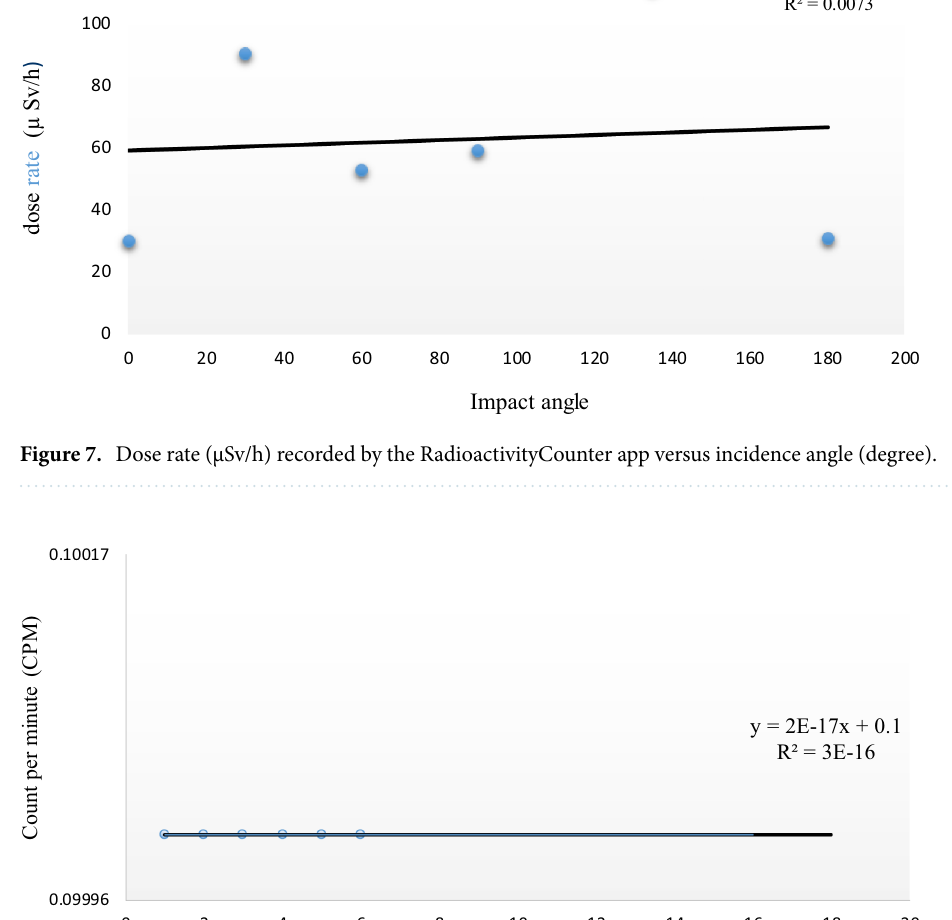
correspond to facing the source and facing away from the source of radiation. The data in Fig. 7 shows that the phone’s front camera CMOS can detect harmful ionizing radiation at any incidental radiation angle. This helps determine the direction of the ionizing radiation from the source to the smartphone 14 . Altering the angle of the incoming gamma rays changes the shielding the gamma rays travel through to reach the sensor. For example, at certain angles, gamma rays will travel through the battery before reaching the camera. This material attenuates the gamma rays and explains why the dose rate is different at different angles. Interactions with intervening mate- rial can also generate high-energy electrons that are then detected by CMOS sensors 15 . ANSTO found that the iPhone 4 s has an angular response independent of angular impact at 50 and 150 µSv/h 8 . Other previous research found that the iPhone 4s ′ angular response is independent at 1000 µSv/h 12 . In contrast, from the results shown in Fig. 8, the iPhone 6s ′ angular response is dependent on its orientation at lower dose rates of around 37.5 µSv/h. Concrete pad measurements. The measured dose rates versus the CPM as acquired by the Radioac- tivityCounter app above the calibration pad number 5 (Fig. 8). No detection was recorded by the phone, as the radiation emitted from this pad is low at nearly 0.35 µSv/h 13 . This level of radiation is under the determined detectable limit. The data recorded by the RadioactivityCounter app at pad number 5 is graphically presented as a relationship between counts per minute versus dose rate (µSv/h), as shown in Fig. 8. Since the app’s sensitivity for radiation detection is limited to 10 µSv/h, there was no detection where the radiation emitted from Pad 5 was at 0.35 µSv/h. This finding corresponds to the developer, in which the sensitivity of this app begins at 10 µSv/h 11 . The lower limit of the CMOS sensor is probably due to the CMOS sensor’s resolution and small size. CMOS sensors have been discussed as a useful tool for dose alarms in environments where workers may be exposed to radiation 16 . However, they are not widely used in safety applications because of their low